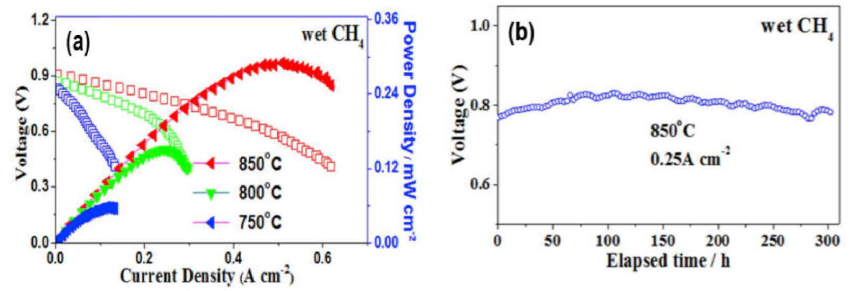
Figure 10. ( a ) Voltage–current curves and ( b ) stability test for the SFCM/LSGM/LSCF SOFC in wet CH 4 (adapted from